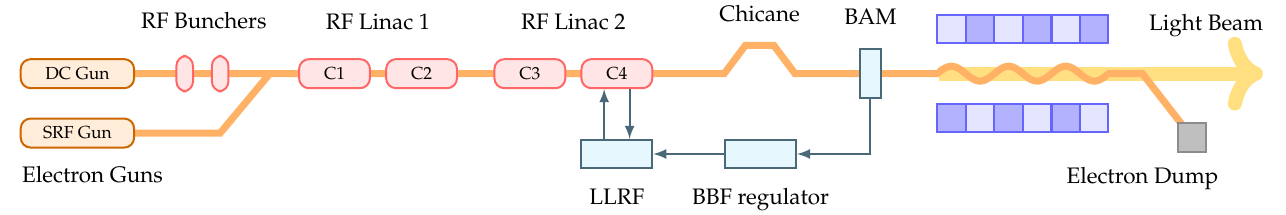
Figure 2. General layout of ELBE THz beamline featuring beam-based feedback regulation